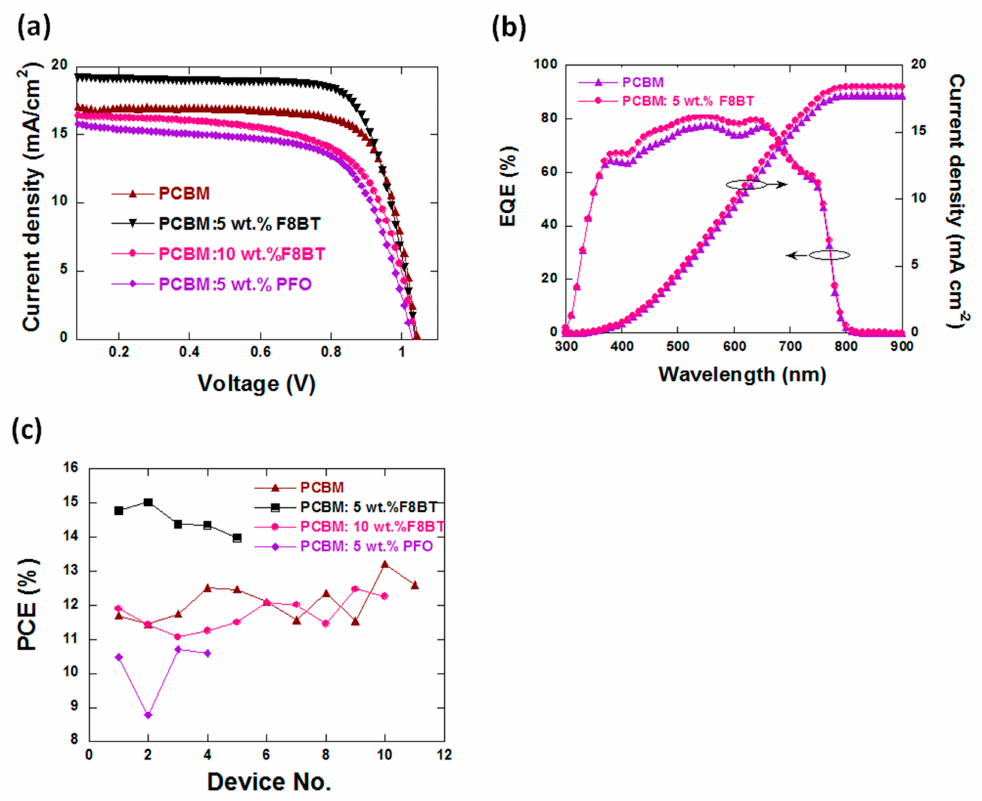
Figure 2. ( a ) Photocurrent density (J)–voltage (V) curves of the devices (under 100 mW · cm − 2 AM 1.5 illumination) with different electron transport layers (ETL), ( b ) EQE data and integrated JSC curves ( c ) and the PCE statistics of PSCs. Table 1. Summary of detailed performance parameters of PSCs.